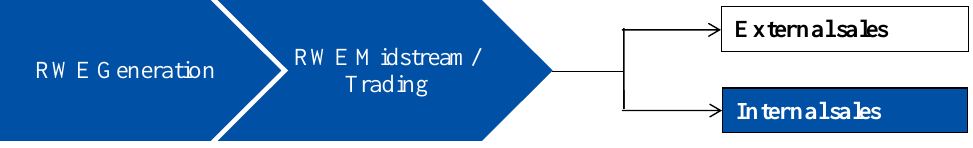
Figure 17. Illustration of synergy cluster “capital requirements“. Own illustration, based on RWE internal